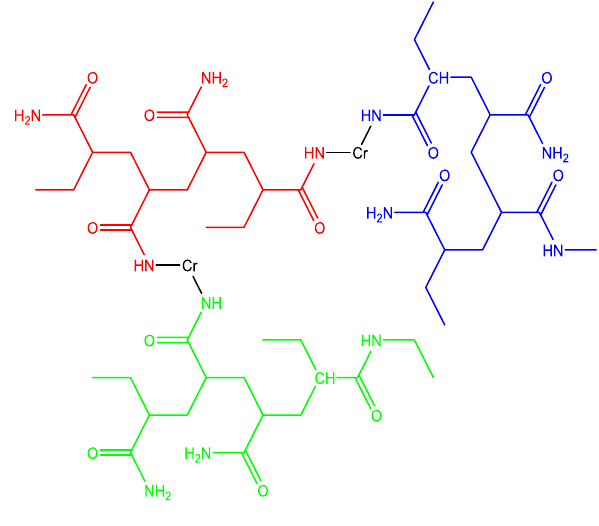
Fig. 2 Cross-linked